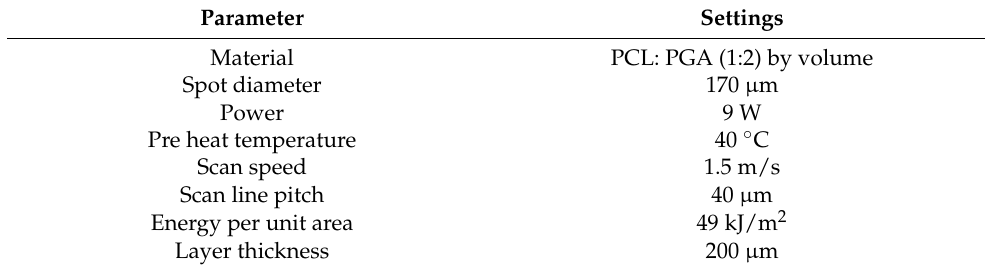
Table 1. Specifications of CO 2 gaussian laser sintering